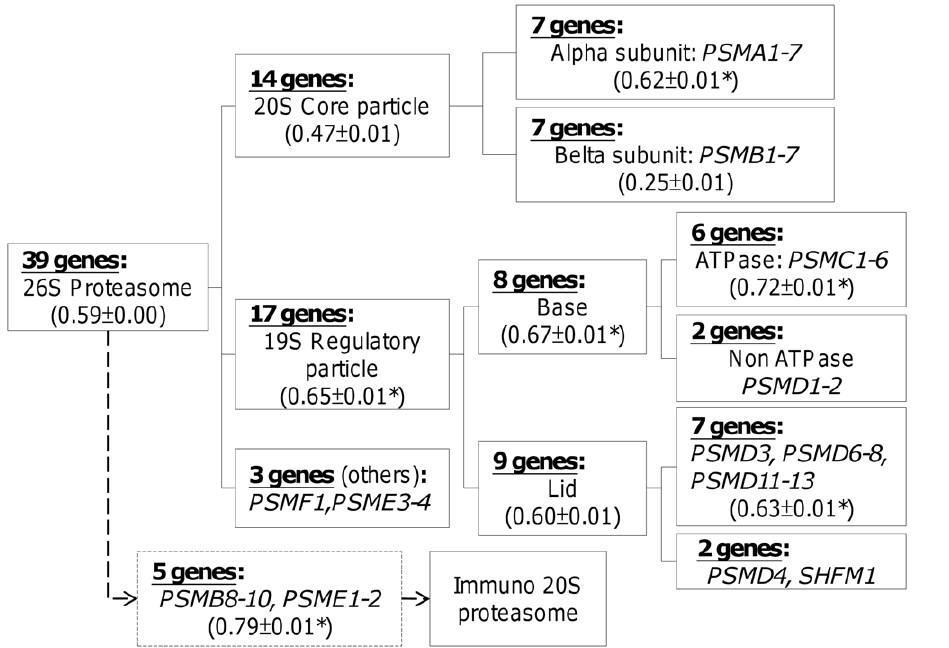
Figure 8. A less coherently regulated subcomplex ( b ) reduced the overall expression ranking preservation of proteasomal genes. Shown are gene expression rankings ( (cid:2) tt tt 0 ) computed for HK genes coding for proteins involved in different subcomplexes of the proteasome. The (cid:2) tt tt 0 value is shown in parenthesis at the bottom of the box. * indicates that the value is significantly different from (cid:2) tt tt 0 computed from random sampling using the same number of genes.